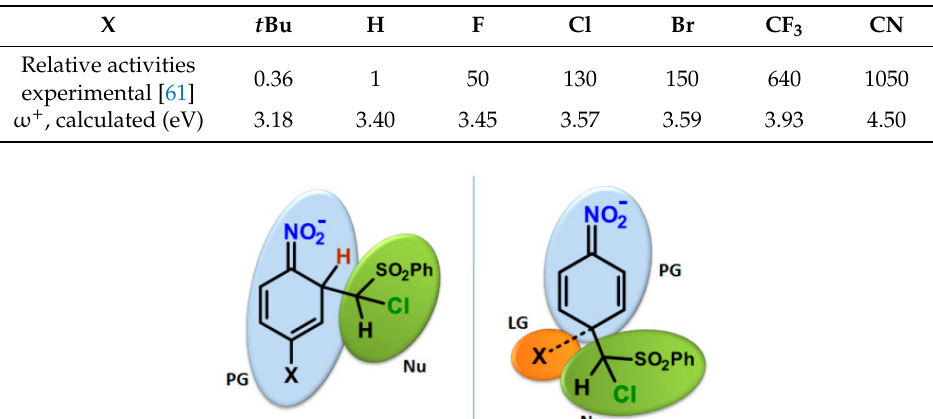
Table 1. Experimental relative activities [61] and calculated electrophilicity potential ω + (eV) of para substituted nitro benzenes.